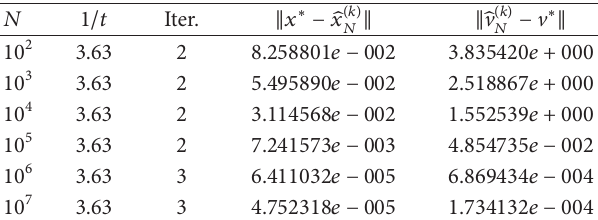
Table 4: The numerical results for Example